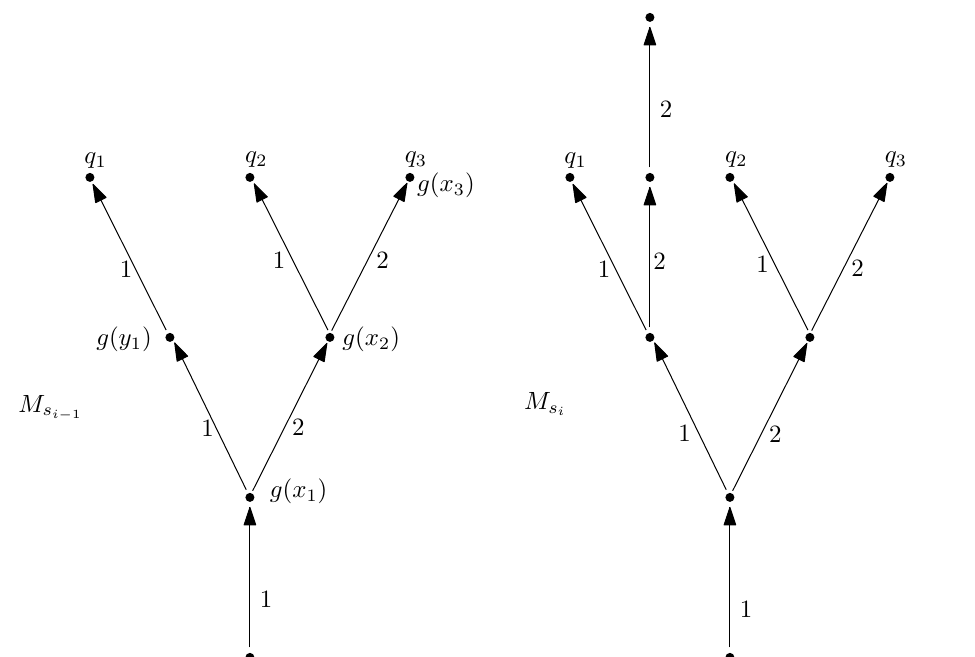
Figure 3. Suppose that s i − 1 = ♦ 1 ( ♦ 1 ♦ 1 q 1 ∧ ♦ 2 ( ♦ 1 q 2 ∧ ♦ 2 q 3 )) and s i = ♦ 1 ( ♦ 1 ( ♦ 1 q 1 ∧ ♦ 2 ♦ 2 (cid:62) ) ∧ ♦ ( ♦ ∧ ♦ )) with M s 2 2 q 3 1 q 2